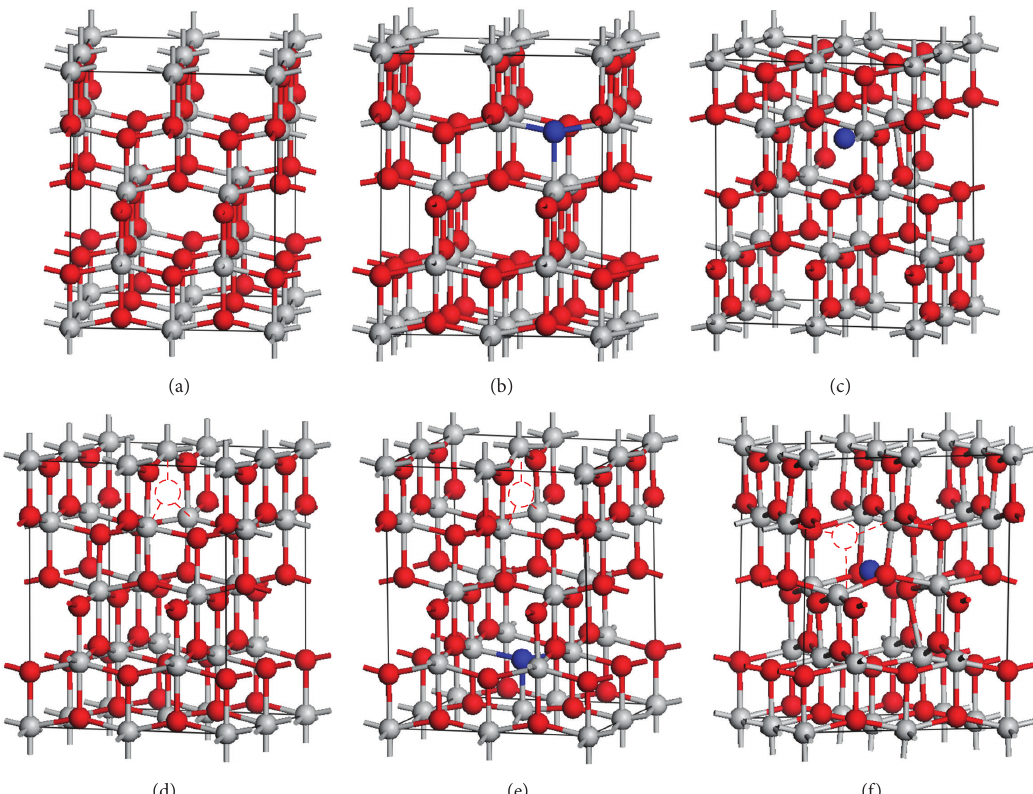
Figure 1: 2 × 2 × 1 anatase TiO 2 supercell models: (a) pure TiO 2 ; (b) substitutional N-doping (N s ); (c) interstitial N-doping (N i ); (d) oxygen vacancy (O v ); (e) substitutional N-doping with oxygen vacancy (N blue, and dotted line spheres represent Ti, O, and N atoms, and oxygen vacancy, respectively.